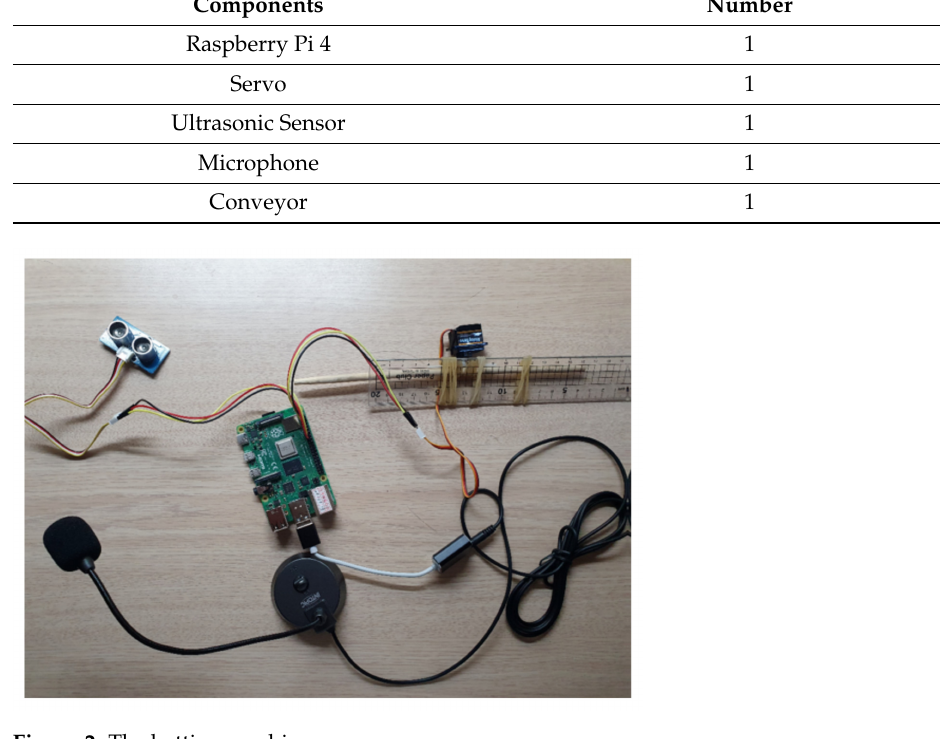
Figure 2. The batting machine.